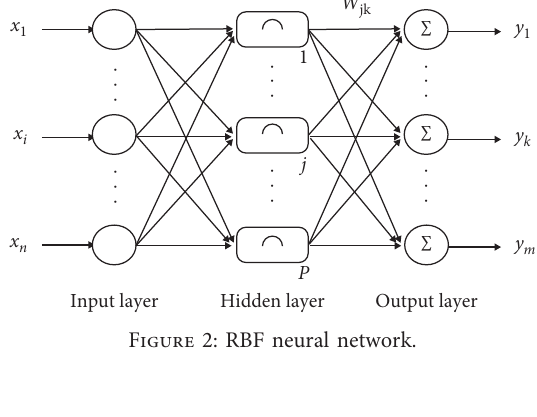
Figure 2: RBF neural